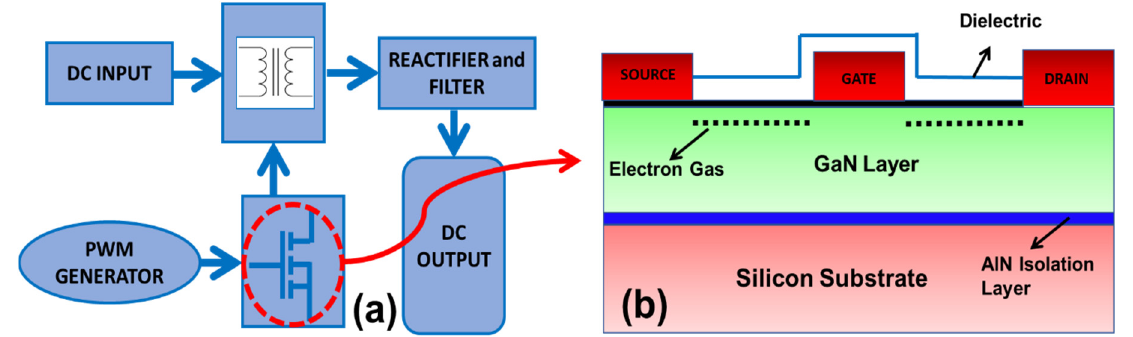
Figure 2. ( a ) Block diagram of flyback topology with PWM as input to the switch; ( b ) the internal structure of a GaN FET.